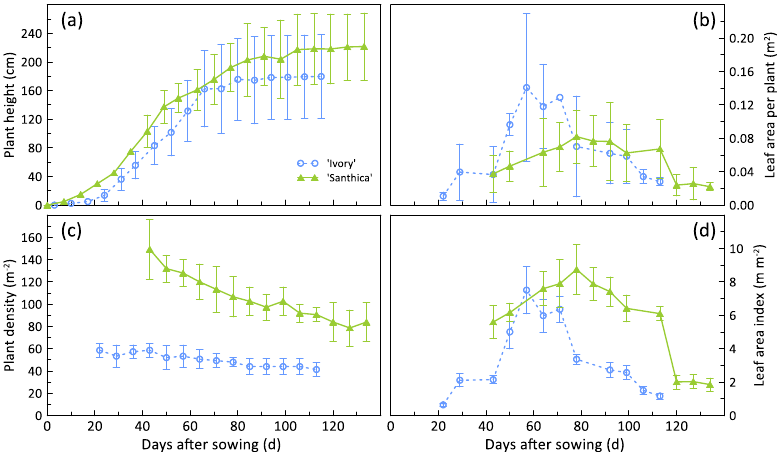
Figure 3. Seasonal growth dynamics of ‘Ivory’ (circles) and ‘Santhica 27’ (triangles) plants as indicated by ( a ) means of non-destructive plant height, ( b ) total leaf area per plants, ( c ) plant density and ( d ) leaf area index.